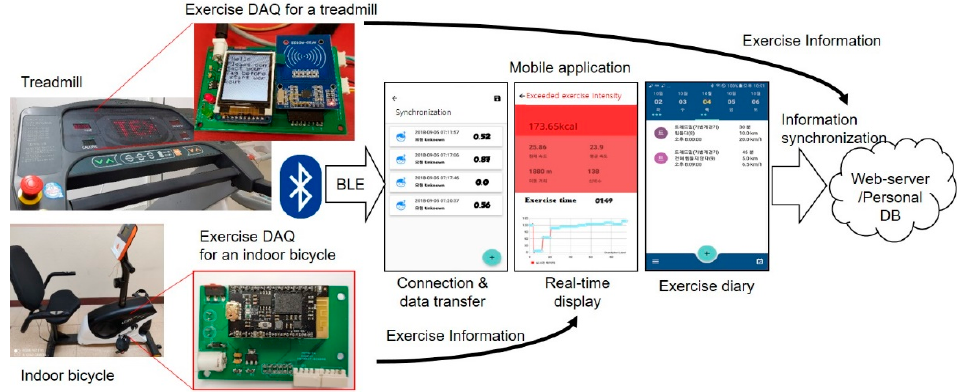
Figure 9. Implementation of exercise DAQ board.